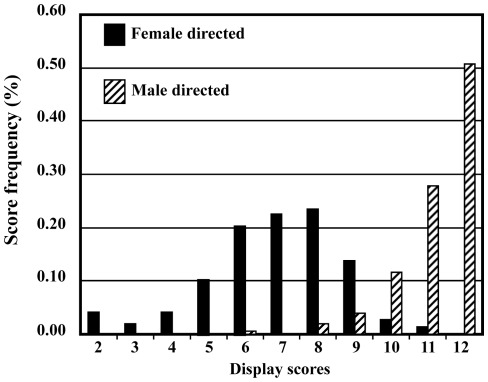
Histogram of the frequency distributions of scores for all female- (n = 148) and male-directed (n = 151) wing-spread song displays recorded from the 7 male brown-headed cowbirds that featured in the playback video stimuli presented to the female subjects.Recordings used as stimuli were selected from these recordings as described in the text. Note the overlap in the distribution of scores for male- and female-directed displays.